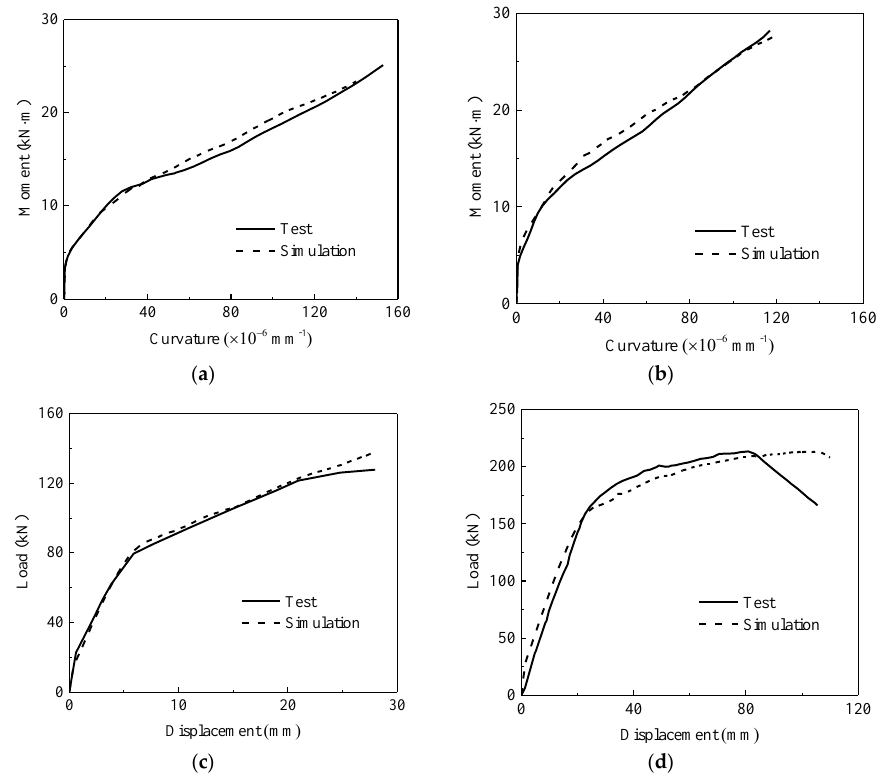
Figure 3. Load–deformation curves: ( a ) A1, ( b ) A2, ( c ) B3, and ( d ) G0.6-T1.0-A90.